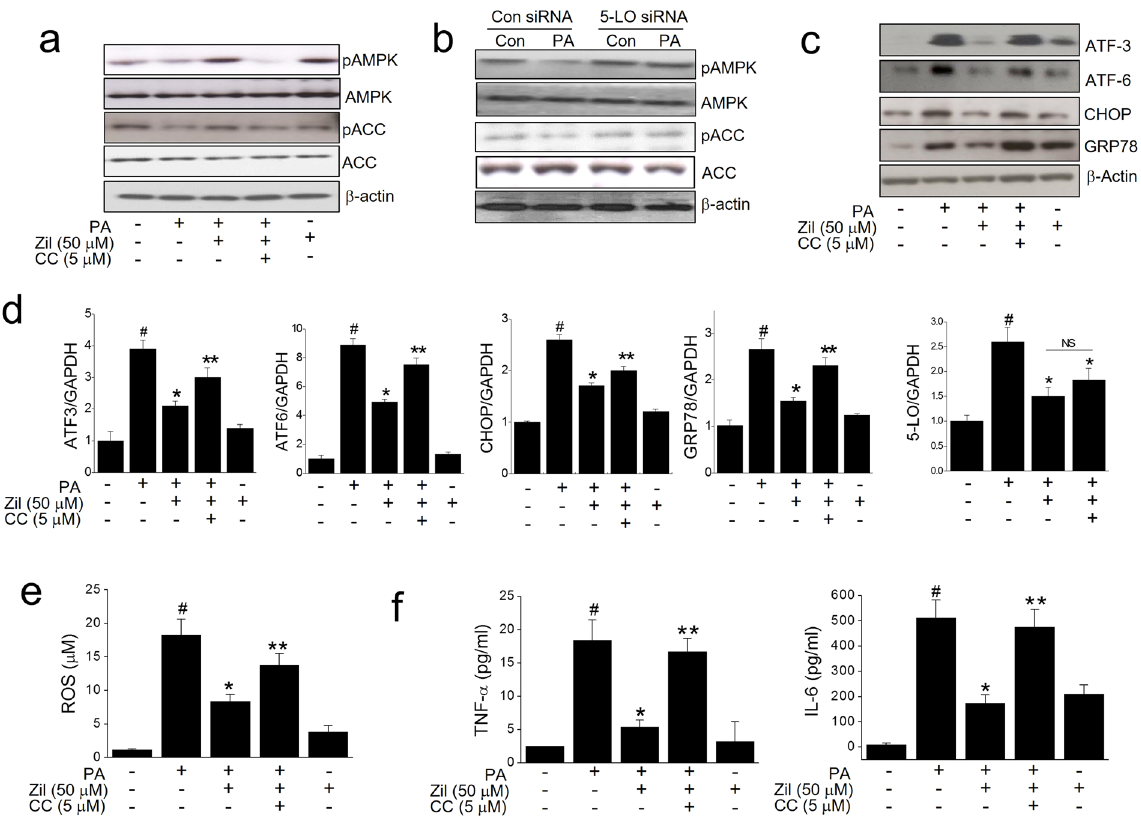
Figure 6. Effects of compound C on the zileuton action. C2C12 myotubes were exposed to 50 μ M zileuton for 1 h in the absence or presence of 5 μ M compound C, and then treated with PA (750 μ M) for 12 h (qPCR) or 24 h (western blot, ROS and ELISA). Phosphorylated AMPK and ACC levels were determined by western blotting ( a ). 5-LO siRNA transfected C2C12 myotubes were treated with PA (750 μ M) for 24 h, and the phosphorylated AMPK and ACC levels were determined by western blotting ( b ). The expression levels of ER stress markers ( c and d ) and 5-LO ( d ) were determined by western blotting ( c ) and qPCR ( d ) after cotreatment of zileuton and compound C followed by PA treatment. ROS production was assessed using AmplexRed ( e ). Levels of TNF- α and IL-6 were determined by ELISA ( f ). The results of the western blotting are shown as the representative of three independent experiments ( a–c ), and other results are expressed as the means ± SDs of three experiments performed in triplicate. # P < 0.05 vs . non-treated controls, * P < 0.05 vs . PA alone, and ** P < 0.05 vs . PA plus